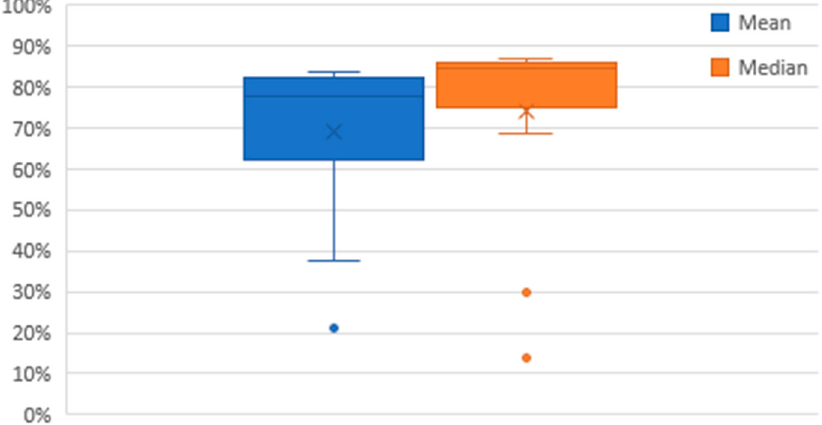
Figure 14. Box and whisker plot of the mean and median values of the SoC ES .